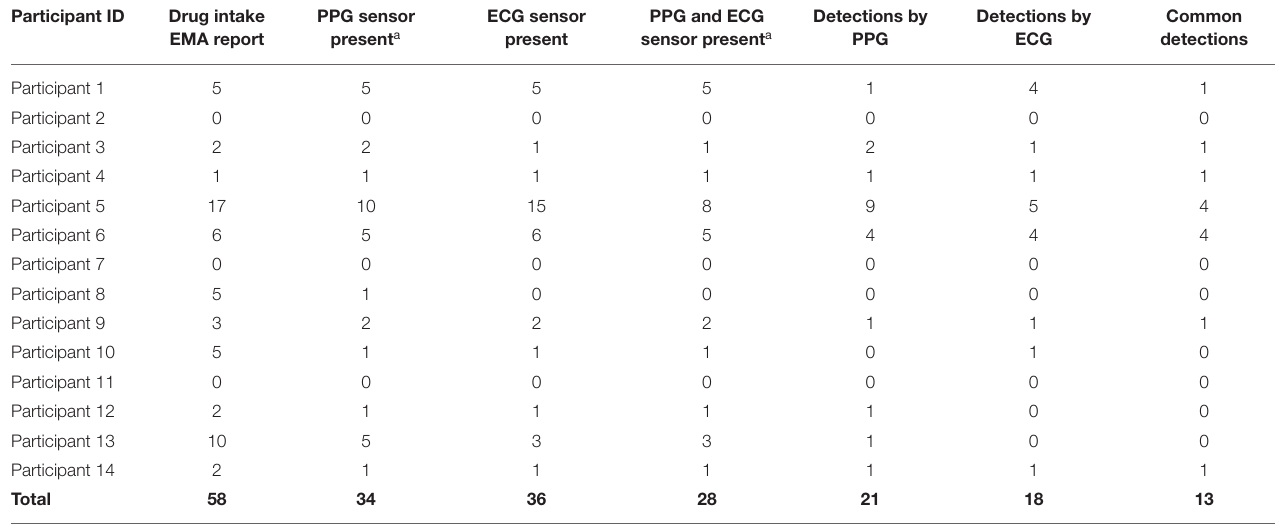
a At least one wrist-worn sensor present.